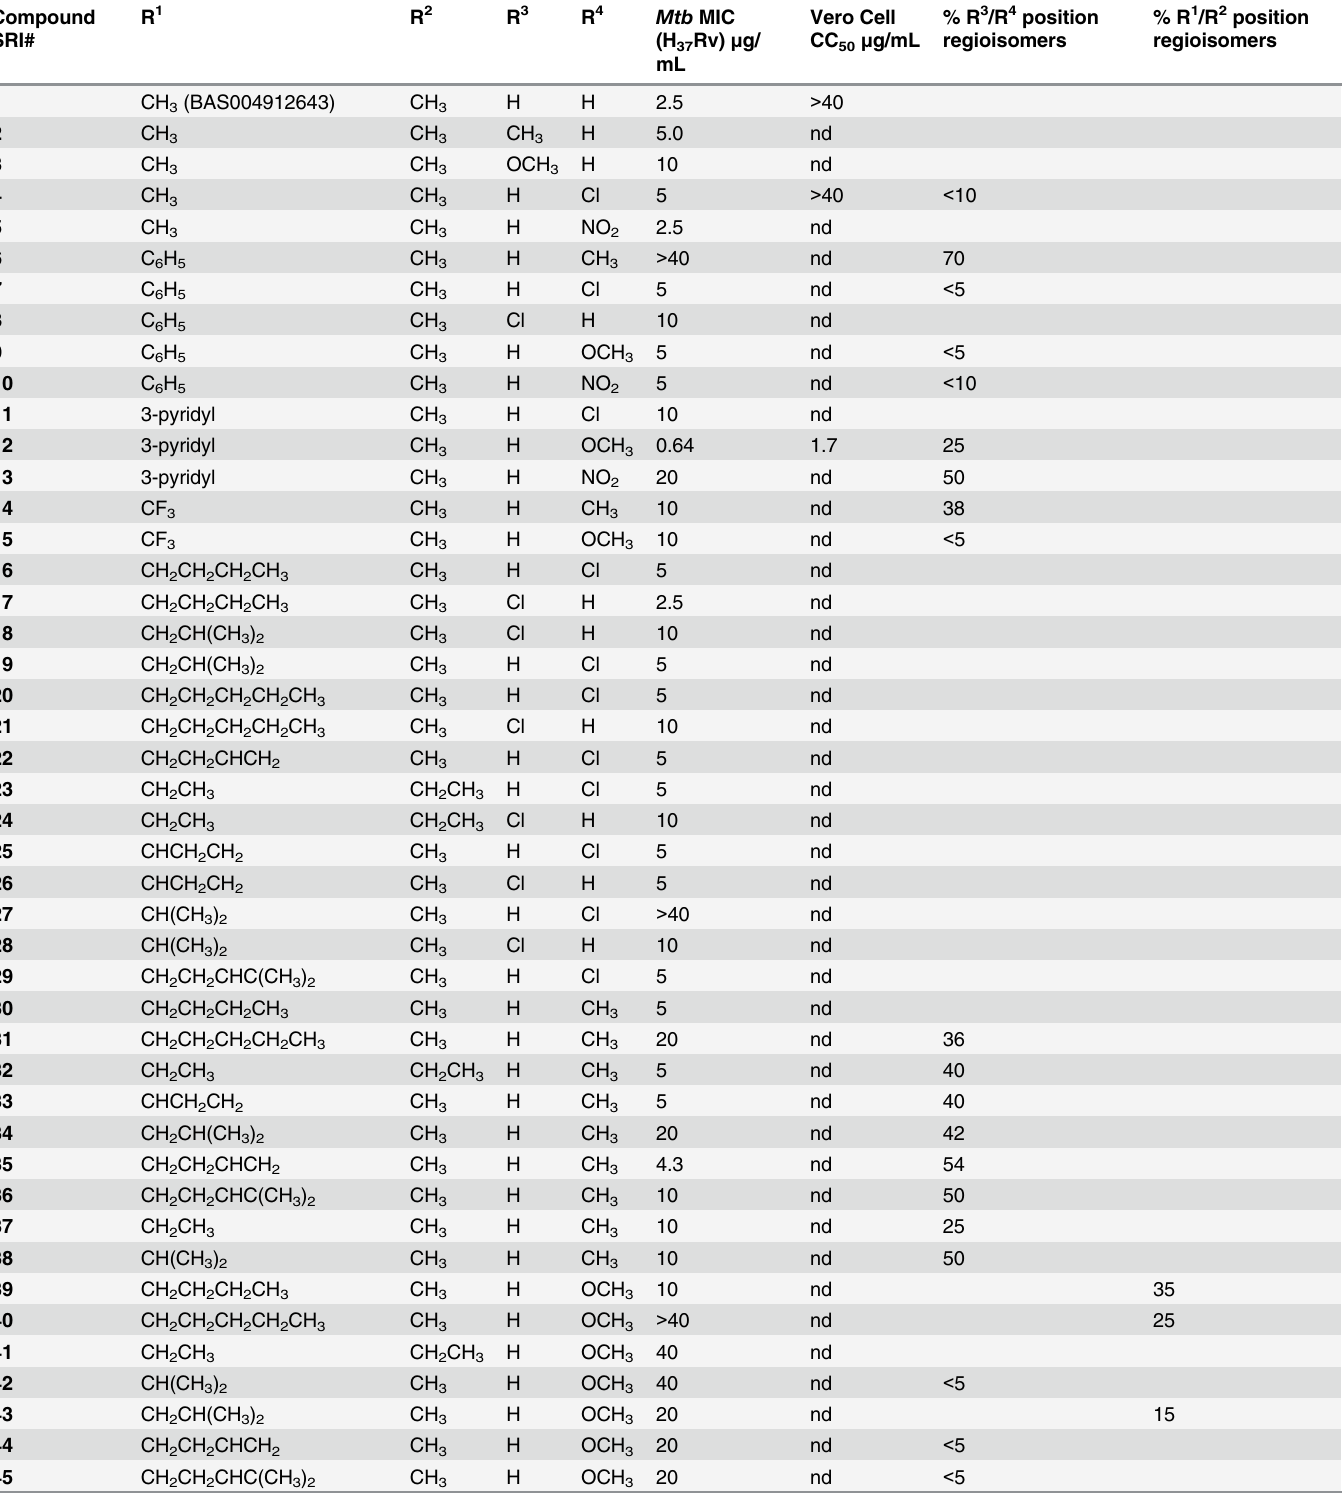
Table 2. Structures and activities of the quinoxaline di- N- oxide family (nd = not determined). Molecule structures are in S1